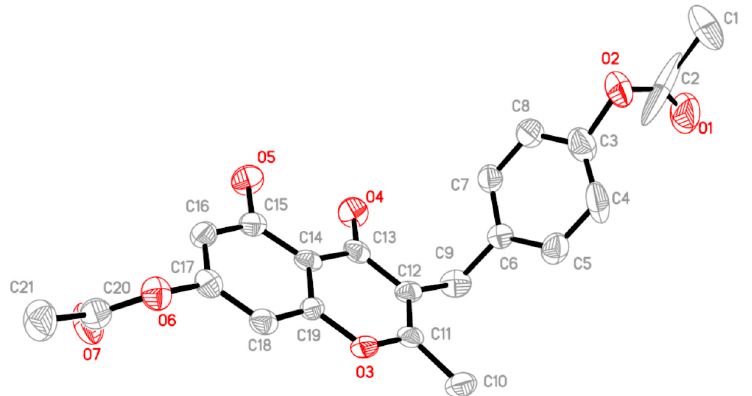
Figure 4. The molecular structure of 11 , showing the atom numbering scheme. For the sake of clarity, H atoms have been omitted. Displacement ellipsoids are drawn at the 30% probability